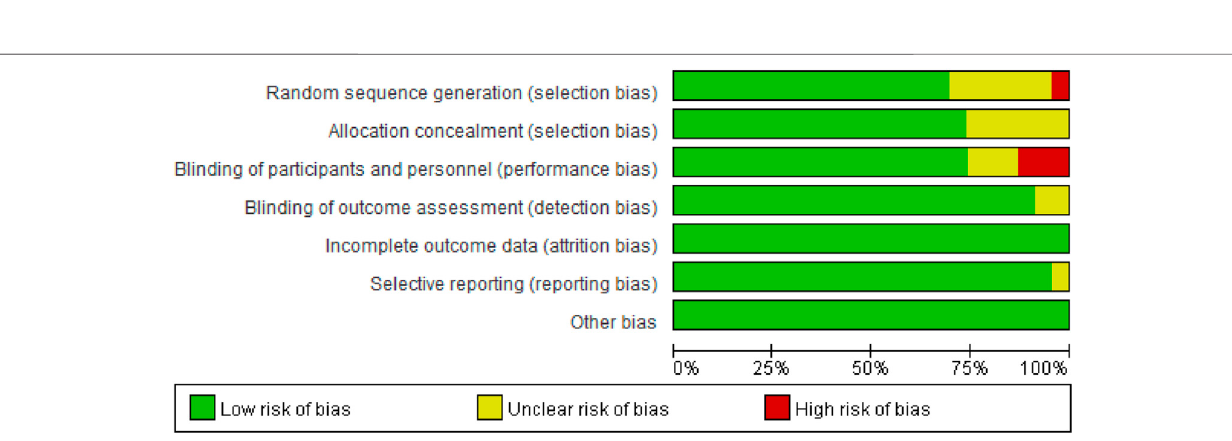
FIGURE 8 | Risk of bias of included randomized controlled